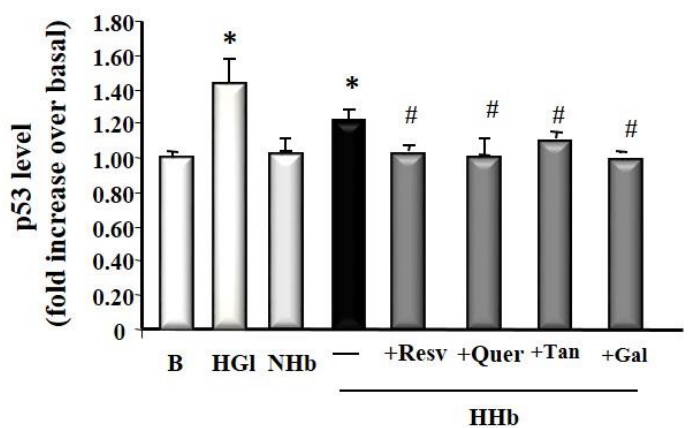
Figure 5. Polyphenols decrease tumour suppressor protein p53 levels induced by Amadori Adducts. Cells exposed for 24 h to different Amadori adducts, HHb and NHb (10 nM), polyphenols: resveratrol (Resv, 12.5 µ M), tannic acid (Tan, 10 µ M), quercetin (Quer, 10 µ M), gallic acid (Gal, 10 µ M); and 25 mM glucose (HGl, High Glucose). For each experiment, 10 independent cultures of HPMCs were used, corresponding to 10 donors. Data represent means ± SD of 7 independent experiments (for each culture of HPMCs corresponding to each of the 10 donors), * p ≤ 0.05 vs. el basal. # p ≤ 0.05 vs. HHb.